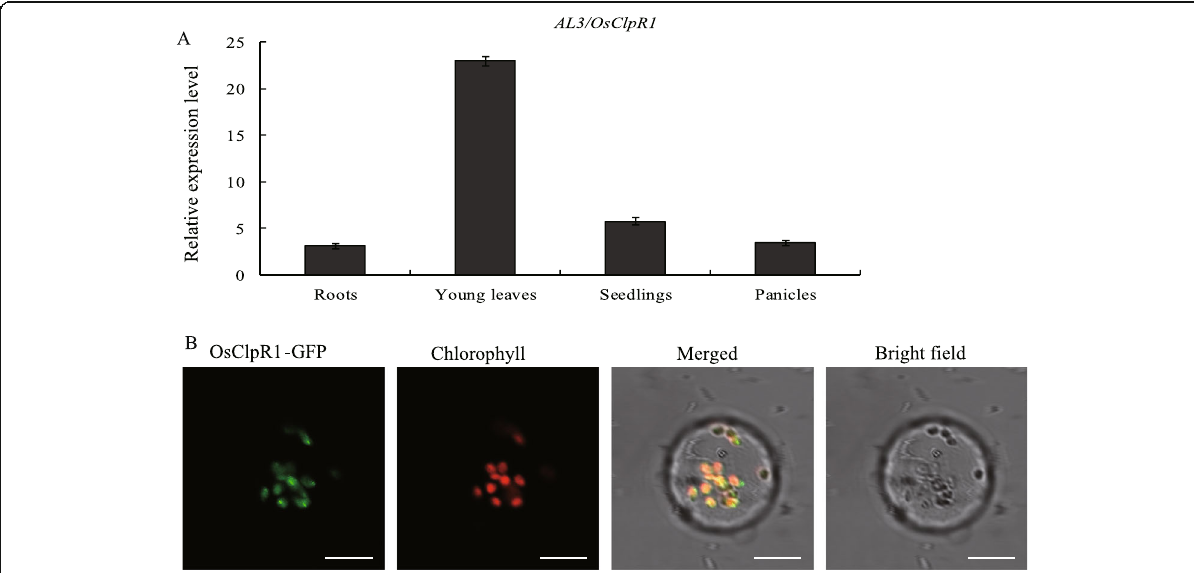
Fig. 5 Expression and subcellular localization of OsClpR1. a Expression of OsClpR1 in roots, young leaves, panicles, and 7-day-old seedlings of wild-type plants. b Subcellular localization of OsClpR1. Green, red and yellow fluorescence show GFP, chloroplast autofluorescence, and the merged fluorescence,